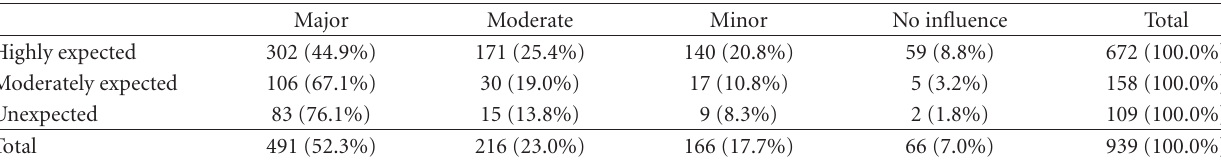
Table 3: Alteration or influence on treatment by 939 chest radiography examinations, grouped according to the referring physicians’ antici- pation of the chest radiography outcome. Unexpected chest radiography results influenced treatment to a higher degree than moderately or highly expected results.